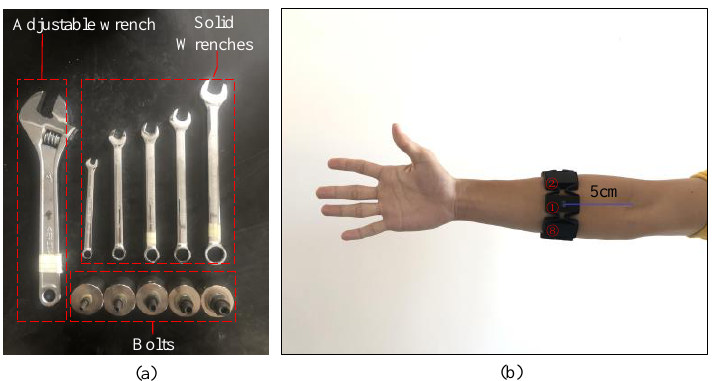
Figure 4. Schematic of bolt assembly tools and Myo armband wearing. ( a ) wrench and bolts used in this test; ( b ) the Myo armband worn on the arm of an operator.